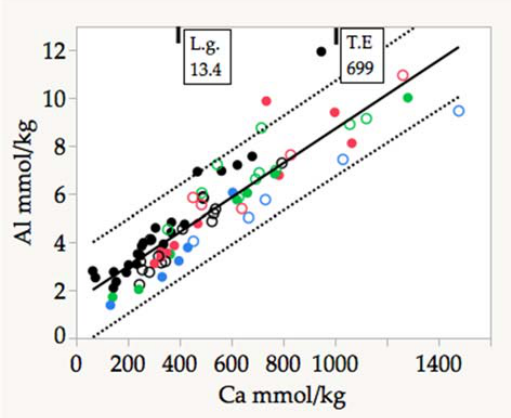
Figure 5. Linear correlation between the concentrations of Ca and Al in adult leaves of karst tree species. The arrows indicate the values of Al accumulators which were not included in the regression. Al (mmol/kg) = 1.55 + 0.007 × Ca (mmol/kg). R 2 adj = 0.825; F = 379, p < 0.0001, n = 81. Symbols are the same as in Figure 4.